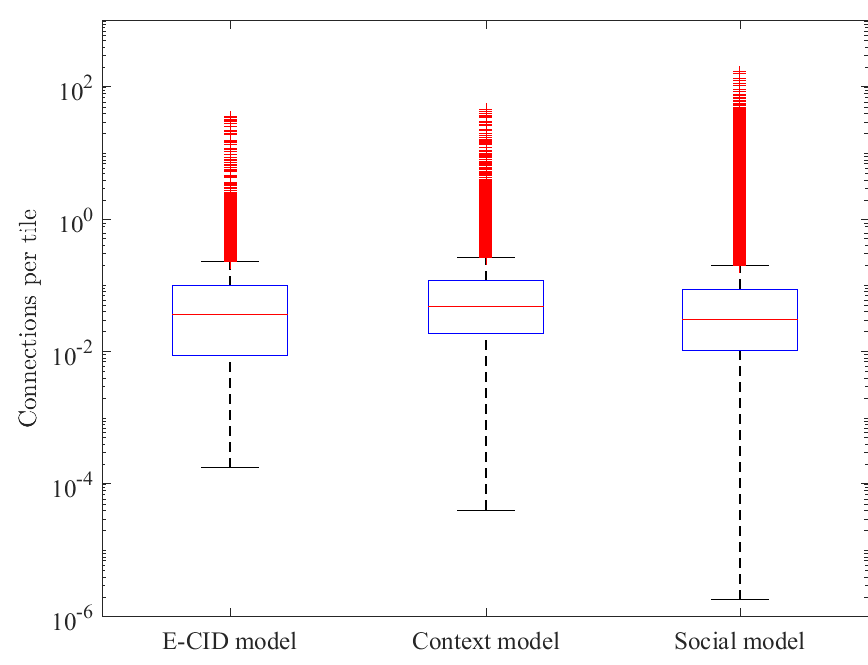
Figure 5. Number of connections per tile by model. Table 3. Statistics of the number of connections per tile with the compared models. 25th